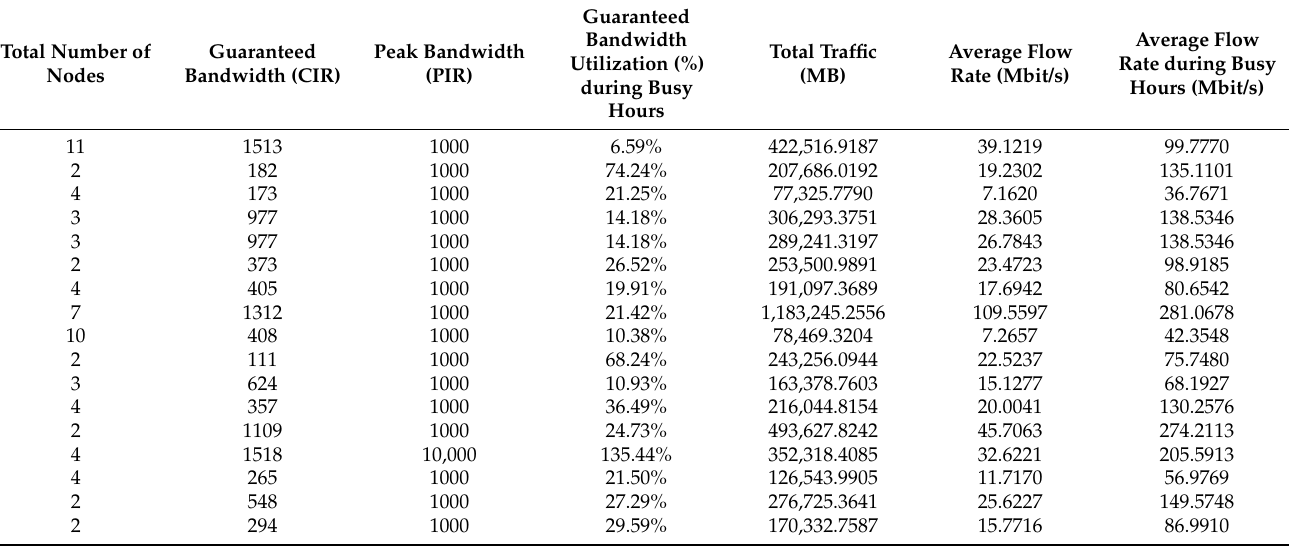
Table 2. Selected data sets for network traffic